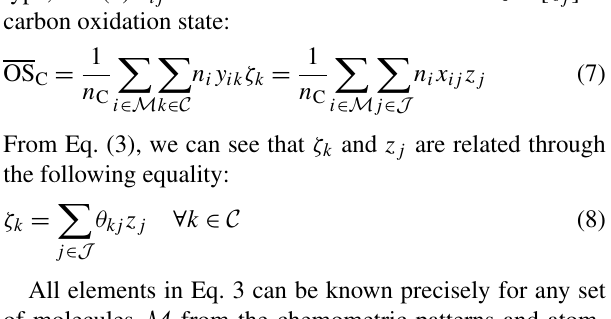
Table 1. Average number of atoms attached to each type of bond assumed for various types of mixtures. λ C , COOH = λ C , carbonyl = 1. Study Mixture type λ C , CH λ C , COH λ C , CONO 2 Allen et al. (1994) ambient 0.5 1 Russell (2003) ambient 0.5 1 Reff et al. (2007) indoor/ambient 0.48 Chhabra et al. (2011) α -pinene SOA 0.63 guaiacol SOA Several ∗ ambient 0.5 0.25 Ruthenburg et al. (2014) ambient 0.5